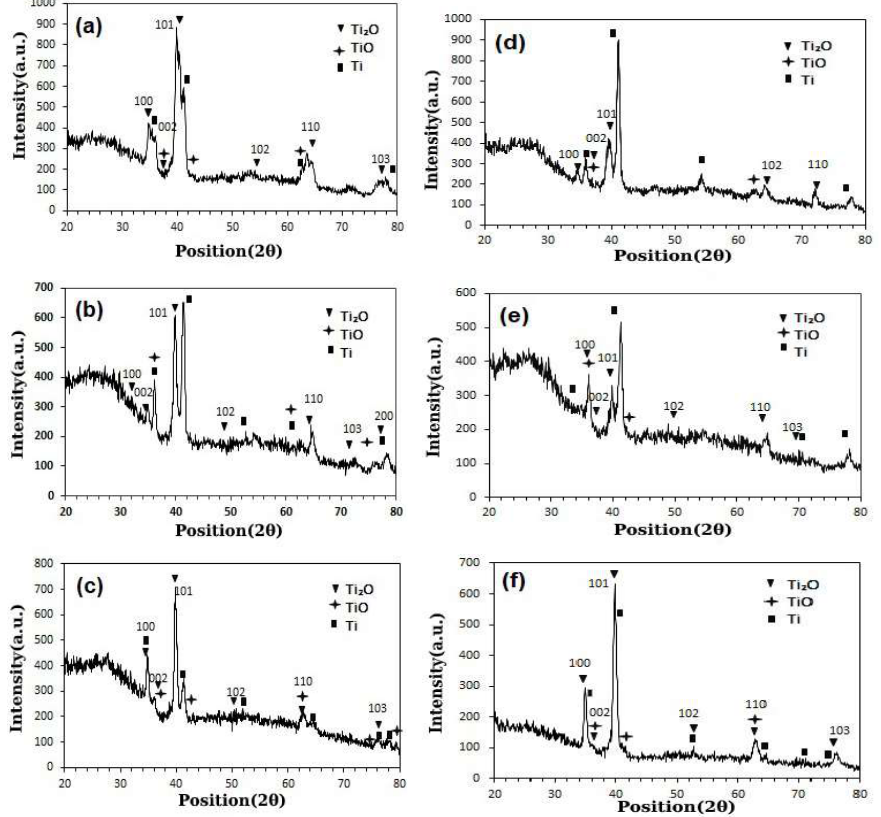
Figure 6. XRD pattern of the anodized surface of Ti-6Al-4V at different times, 10 min ( a ), 20 min ( b ), 30 min ( c ), 40 min ( d ), 50 min ( e ), and 60 min ( f ).